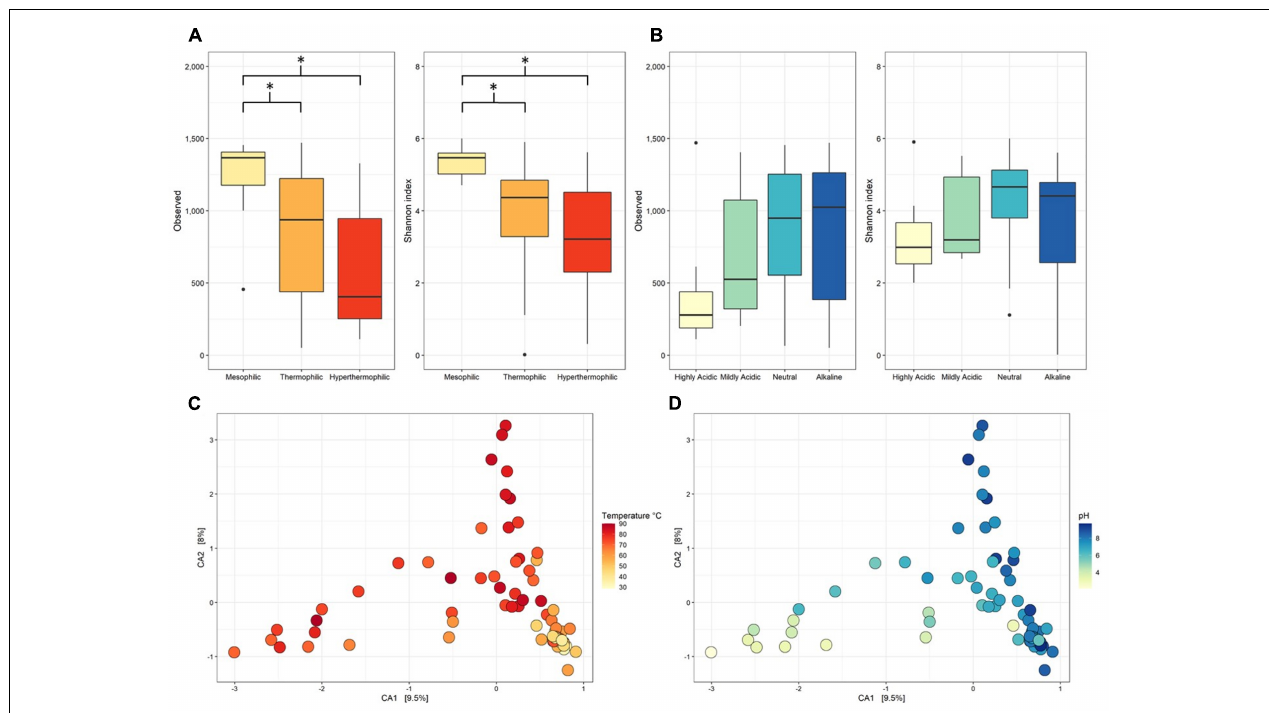
FIGURE 2 | Observed taxa and Shannon Diversity metrics for the taxonomic profile assignment of metagenomic contigs at genus level classification. Taxonomy was assigned to metagenomic contigs using the Kraken2 standard database and contig abundances were calculated using Bracken. (A) α -diversity split by temperature categories, which were: mesophilic ( < 45.0 ◦ C), thermophilic (45.0–79.9 ◦ C), and hyperthermophilic ( > 80.0 ◦ C). (B) α -diversity split by pH categories, which were: highly acidic ( < 4.0), mildly acidic (4.0–5.9), neutral (6.0–7.9), and alkaline ( > 8.0). * denotes significance p < 0.05. Statistics calculated with pairwise comparisons and p -values adjusted by the Holm method. (C,D) Canonical correspondence analysis (CCA) of β -diversity calculated by Bray Curtis dissimilarity with points colored by sample temperature or pH,